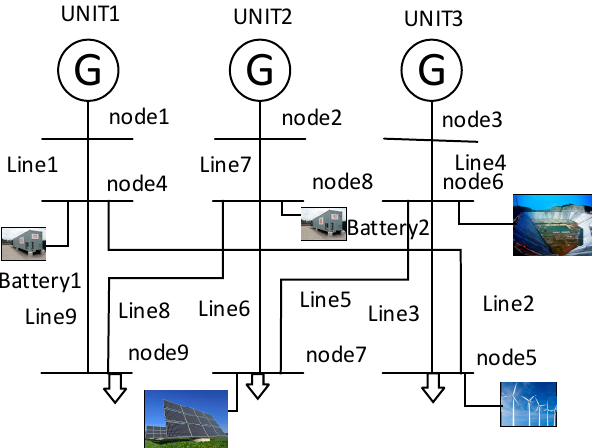
Figure 2. Wind-photovoltaic-thermal power generator, hydro-pumped storage, and battery combined system. Table 1. Thermal power generator parameters.